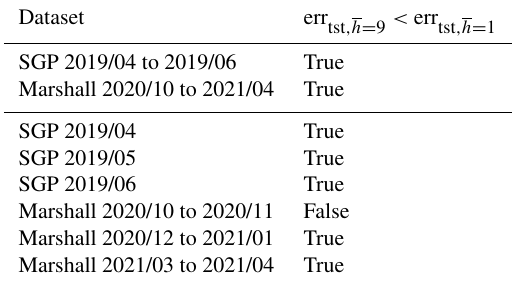
Table 6. This table shows for which datasets the test error of the PTV-MPD method with the coarse-to-fine configuration (cid:16) (cid:17) err is smaller (i.e., better) than PTV-MPD without the tst ,h = 9 (cid:17) (cid:16) . The first two rows of the coarse-to-fine configuration err tst ,h = 1 table, before the horizontal divider line, correspond to the total test error comparison over all the SGP and Marshall datasets. The rest of the rows correspond to the test error comparison over the specific SGP and Marshall